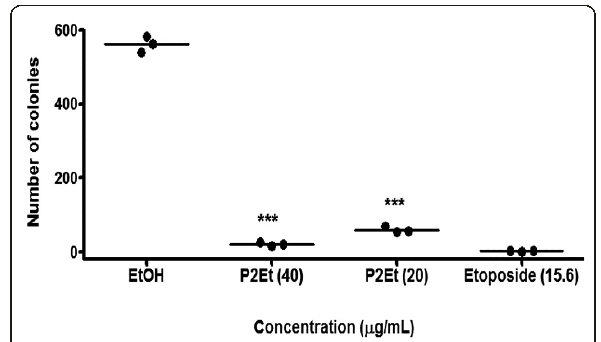
Figure 4 Abrogation of clonogenic activity in K562 cells by the P2Et fraction . Cells were treated with the P2Et fraction, ethanol as negative control and etoposide as positive control. Data represents the mean number of colonies ± SE of 3 independent experiments. ***(p < 0.001) versus control.